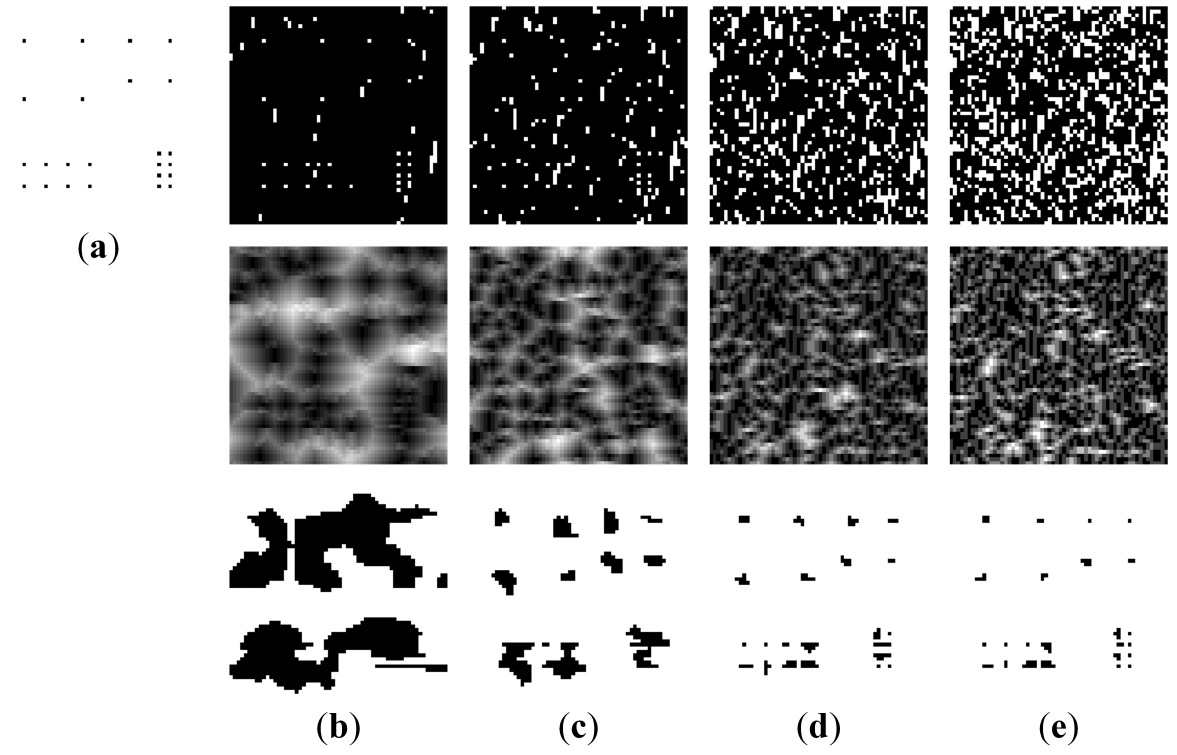
Figure 8. The initial dot-skeleton image ( a ) and SOP at different δ : the first row represents initial conditions; the second row—patterns; the third row—difference images. ( a ) δ = 0 . 001 ( b ) δ = 0 . 01 ( c ) δ = 0 . 1 ( d ) δ = 0 . 2